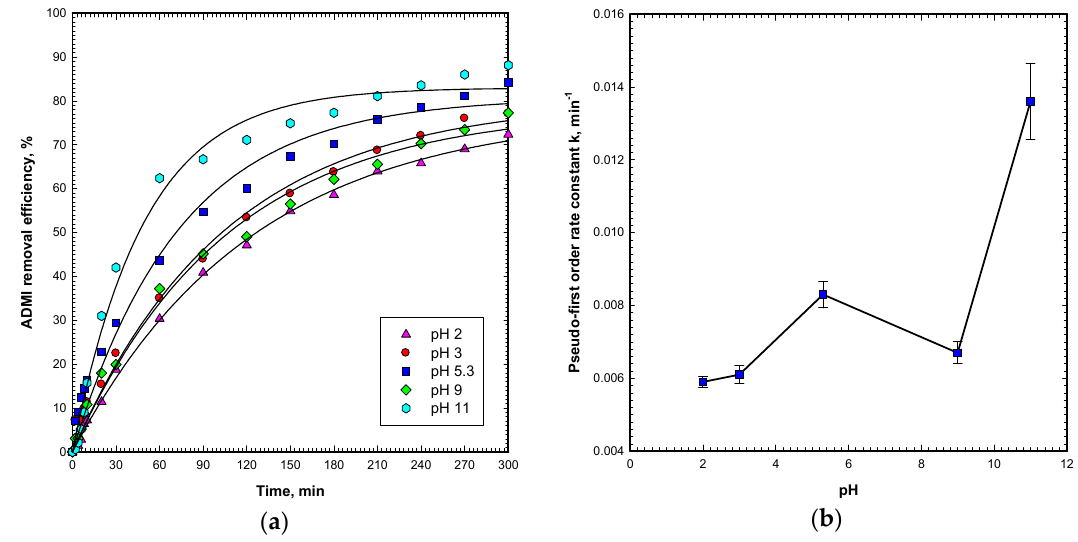
Figure 6. Effect of pH on ( a ) OG degradation and ( b ) the first-order rate constant by the Vis/ZnO process. The operating conditions were: initial OG concentration of 50 mg L − 1 , ZnO dosage of 60 g m − 2 , visible light intensity of 9600 Lux, pH 2–11, and reaction time duration of 300 min.